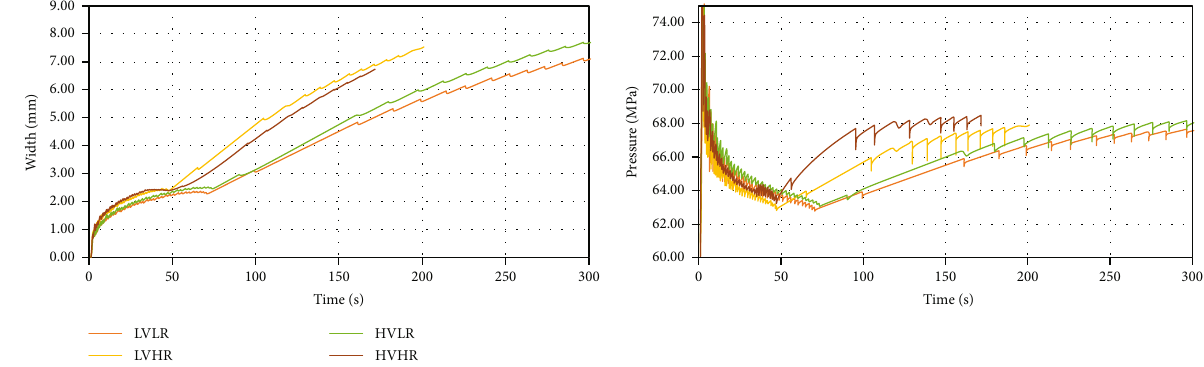
Figure 11: The in fl uence of fl uid viscosity and injection rates on injection pressure and fracture width.